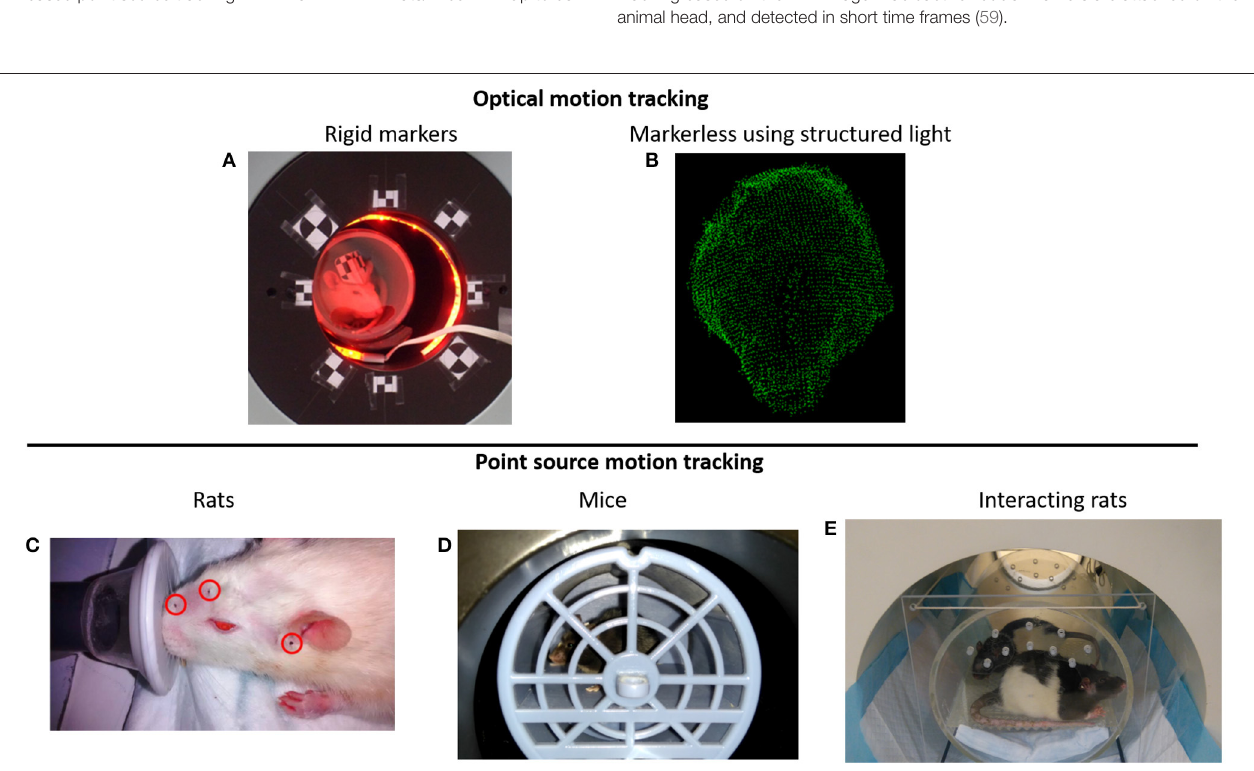
FIGURE 2 | (A) Rat head motion tracking in the Siemens Inveon microPET scanner using the Micron Tracker device (60). (B) Example of a rat head point cloud calculated using structured light projection ( 58). (C) Point sources attached on the rat head for PET motion tracking (59). (D) Awake mouse brain PET scan using the point source tracking (32). (E) Awake PET scan of interacting rats performed in the HRRT scanner using the point source tracking